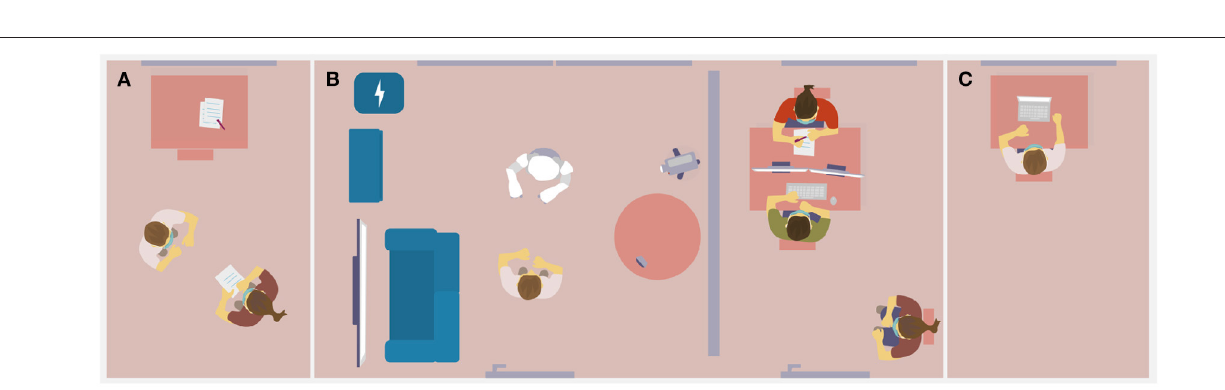
FIGURE 9 | The experimental setup and procedure including (A) the participant being introduced to the robot and the task by the experimenter, (B) the actual human-robot interaction supervised by technicians and, (C) a post-interaction survey taken in a separate